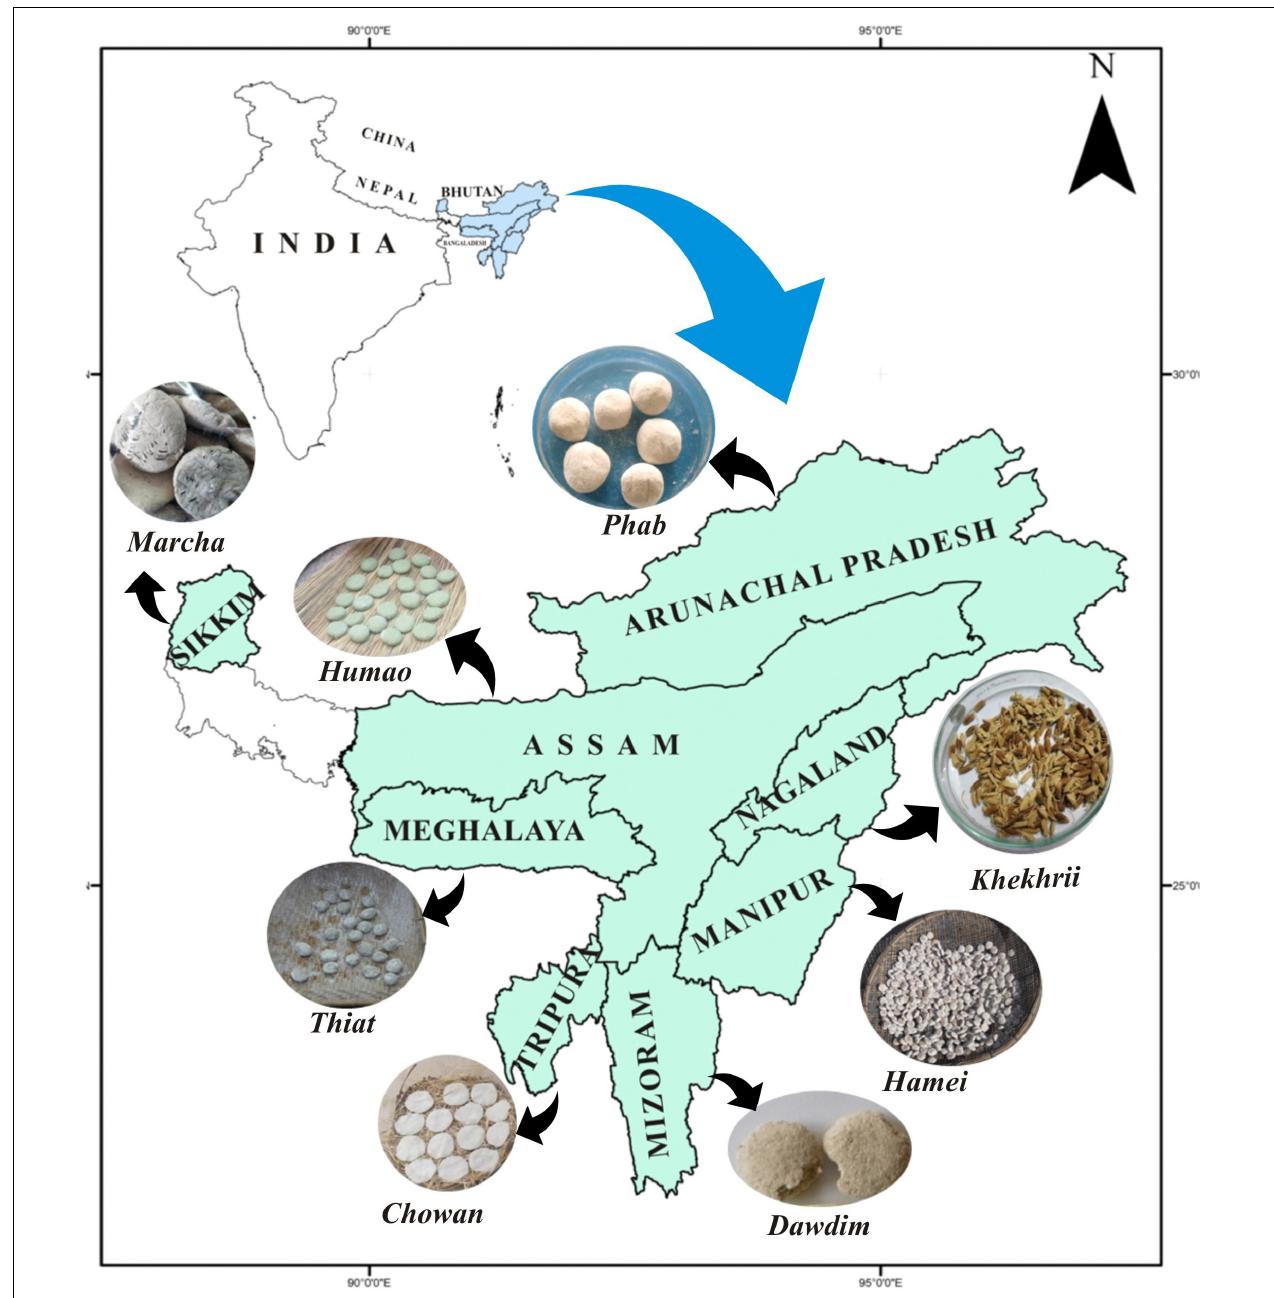
FIGURE 1 | Location map of North East India showing collection sites of traditionally prepared dry starters.